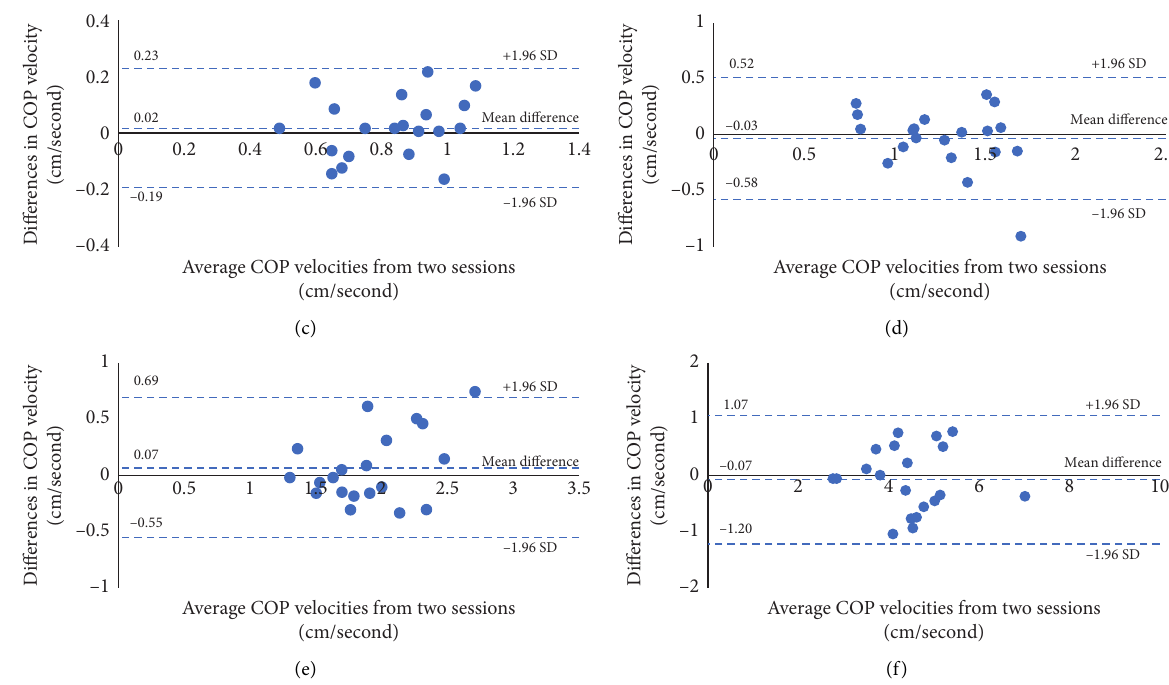
Figure 8: Bland–Altman plots and limits of agreements (LOAs) of COP velocities in sessions 1 and 2 in six testing conditions. (a) COP velocity during DLS-SW-EO. (b) COP velocity during DLS-SW-EC. (c) COP velocity during DLS-FT-EO. (d) COP velocity during DLS-FT- EC. (e) COP velocity during SLS-EO. (f) COP velocity during